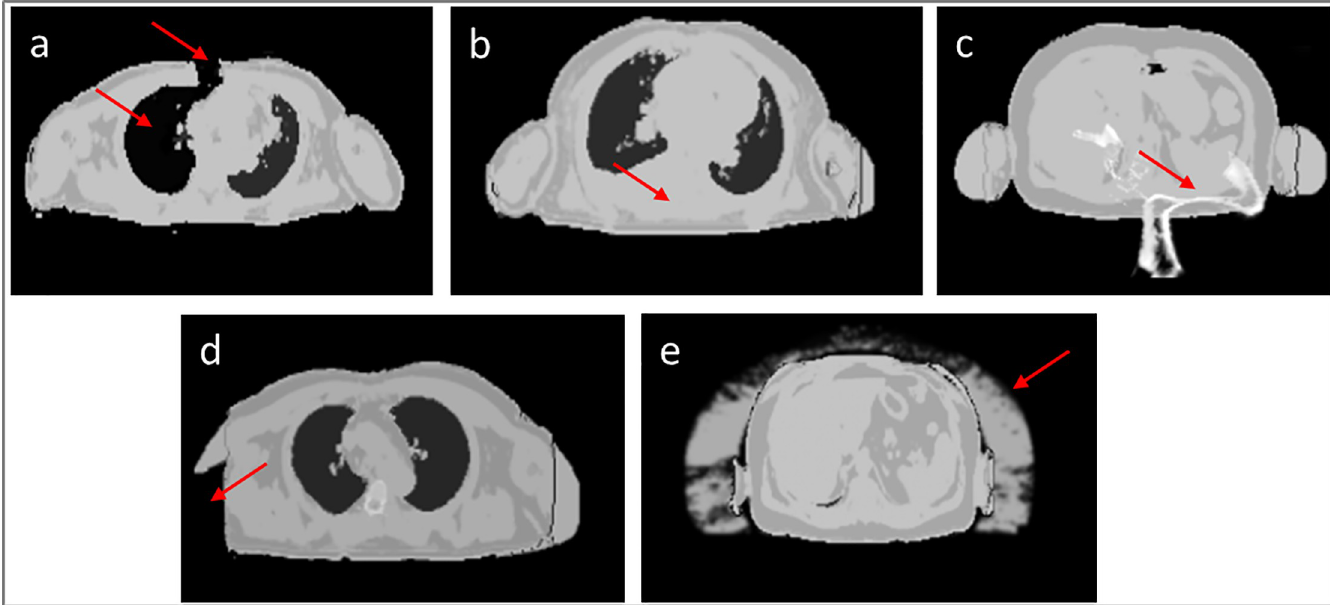
Fig 6. Different AC-map artifacts. Red arrows show AC-map artifacts. In 3/32 patients metal artifacts in Dixon-VIBE AC-map (caused by metal wire cerclage) leads to misclassification of surrounding tissue as “air” (a). Note that in this example the thorax is virtually opened due to the metal artifact (a). Consequently, the segmentation algorithm classifies the lung tissue of the right lung as air and assigns a lower attenuation value in this region (a). In 3/32 AC-maps no bone was segmented (b). In 4/32 patients the bone segmentation mismatches the anatomy (c). In 1/32 patient missing arm segmentation in HUGE imaging occurred (d), and in all 32/32 patients overestimation of AC-map volume in MLAA AC-maps was observed